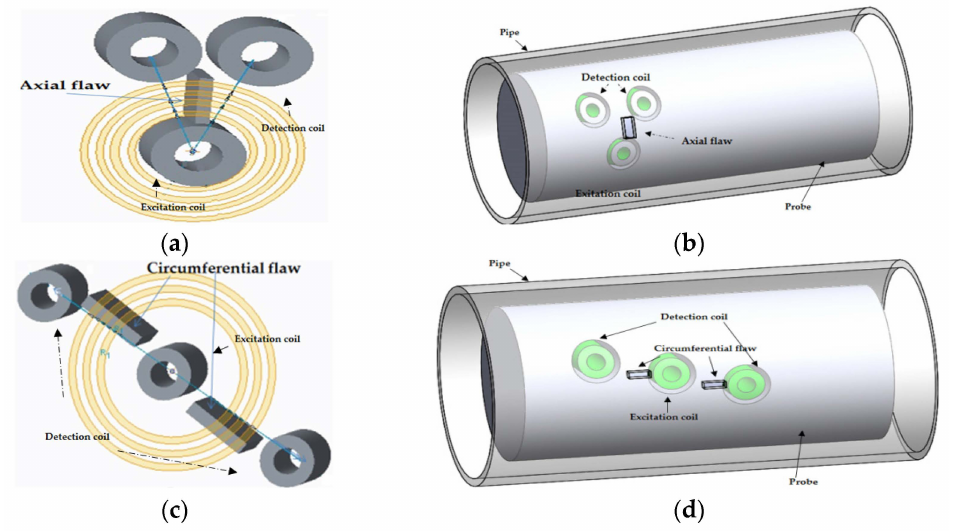
Figure 6. Axial and circumferential channels of array probe: ( a ) Axial channel configuration; ( b ) illustration of the axial channel excitation and detection coil location on the eddy current testing probe ( c ) circumferential channel configuration; ( d ) illustration of the circumferential channel excitation and detection coil location on the eddy current testing probe.